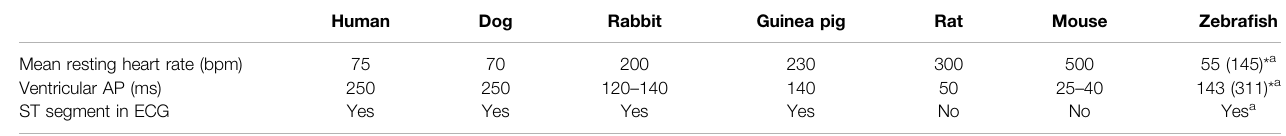
TABLE1| Keyelectrophysiologicalcharacteristicsinhumanandselectedexperimentalanimalspecies.AP,actionpotential;bpm,beatsperminute;ms,milliseconds.*Asin ectotherms,the heartrate anddurationofventricular APinzebra fi sh varywithbody temperature,and numbers indicate heartrate/ventricular APduration at 28 ° Cand at 19 ° C (in parentheses),